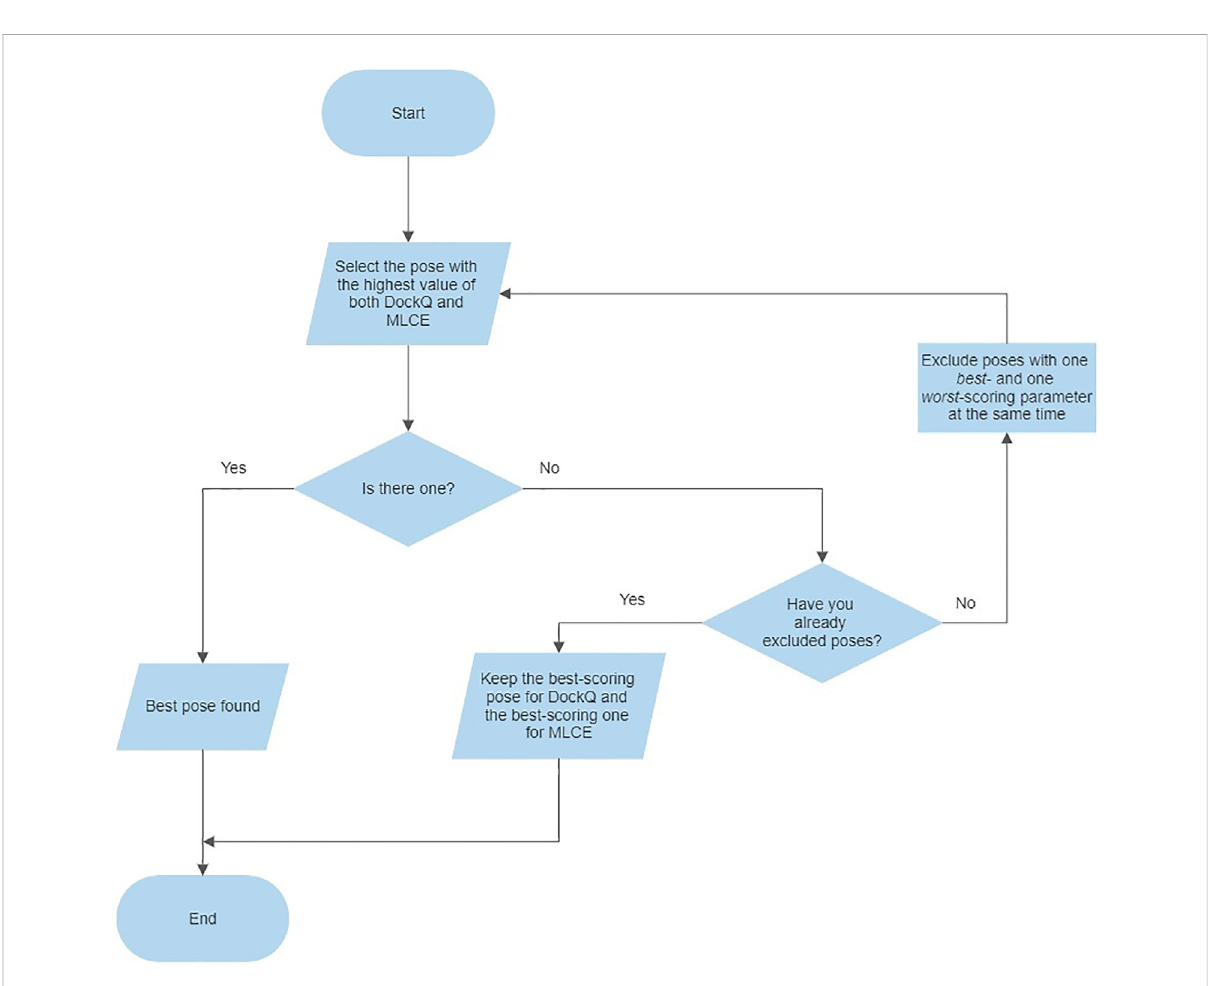
FIGURE 3 Flowchart describing the consensus approach